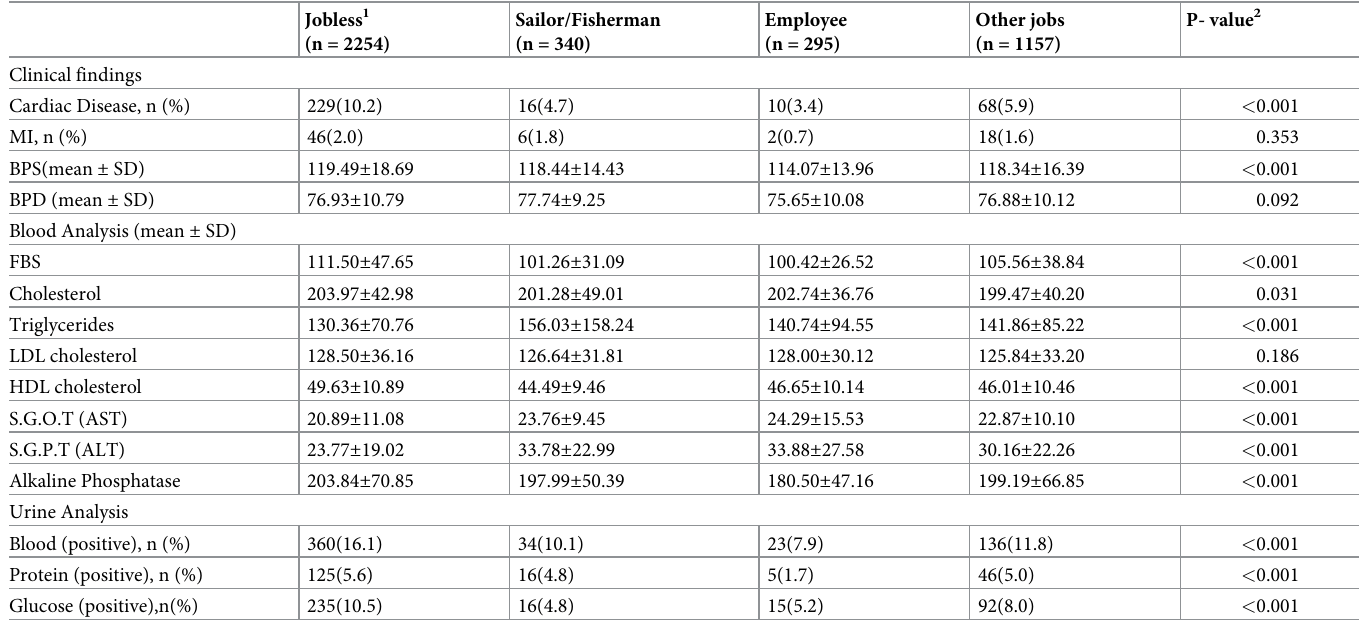
Table 9. Comparison of major clinical and laboratory findings among jobless people, sailors/fishermen, employees and other occupations.